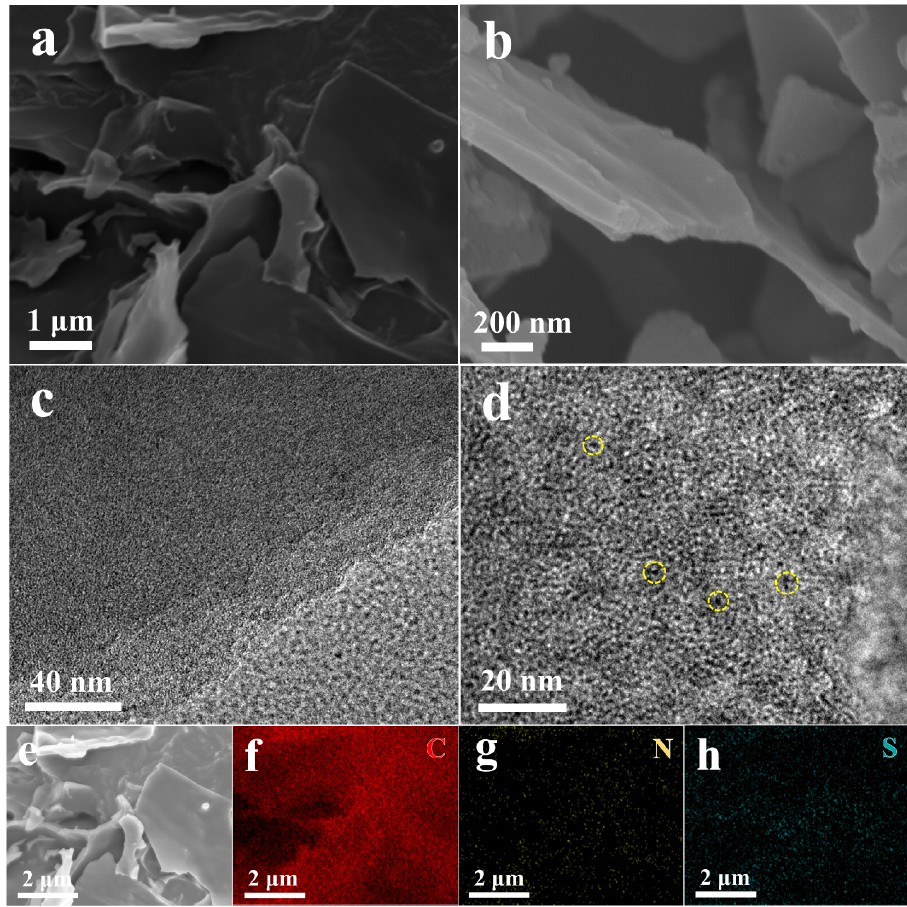
Figure 1. ( a , b ) SEM images of N/S ‐ co ‐ doped porous carbon sheets (N/S ‐ CS); ( c , d ) TEM and high ‐ resolution transmission electron microscopy (HRTEM) images of N/S ‐ CS; ( e – h ) elemental mapping images of N/S ‐ CS.